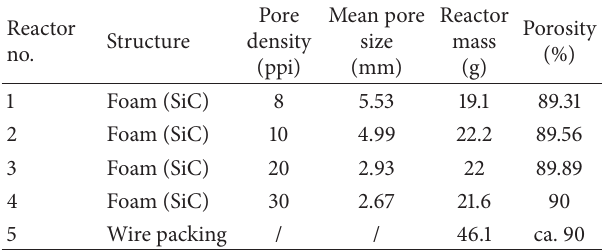
Table 1: Characteristics of investigated porous